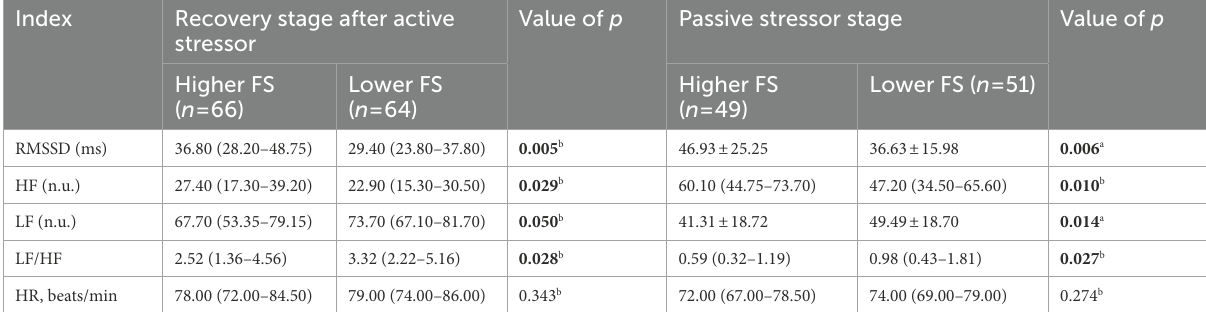
TABLE 5 HRV indices between the recovery stage after the active stressor and the passive stressor in the higher and lower FS groups.